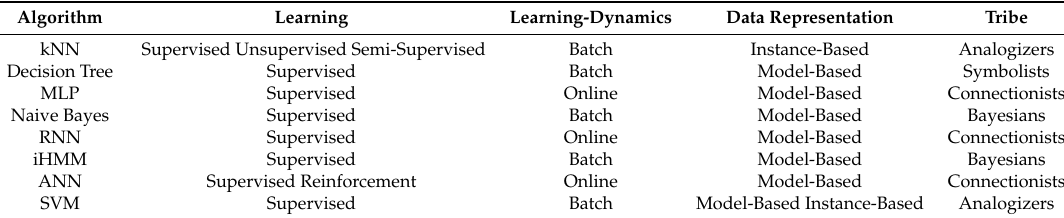
Table 2. Algorithms and their